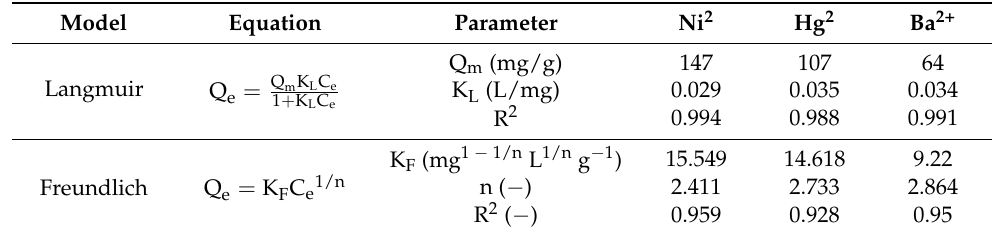
Table 2. Equilibrium parameters for Ni 2+ , Hg 2+ , and Ba 2+ adsorption at 25 ◦ C (single-component aqueous solutions) onto CS-HMF